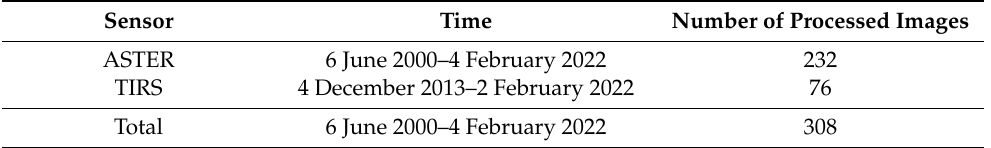
Table 2. Satellite images considered for the